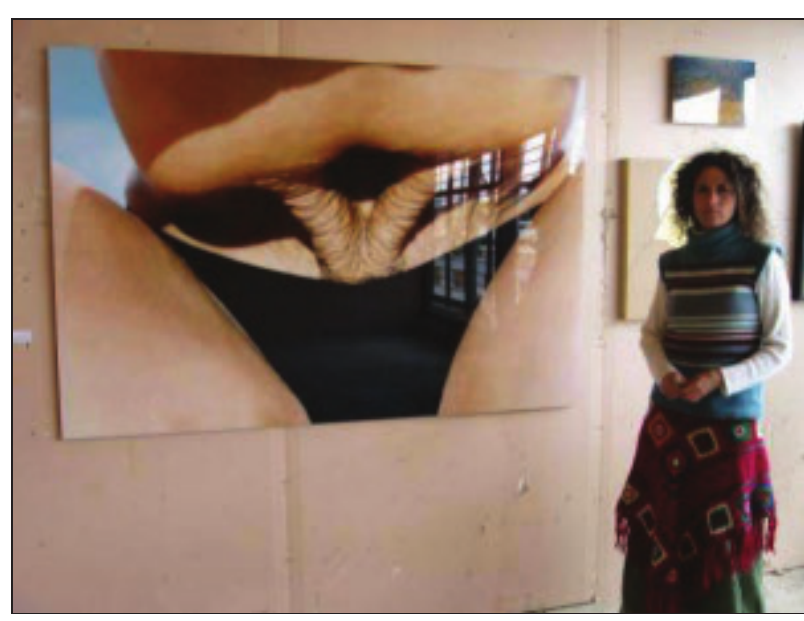
Figure 36: Shira Richter, the artist, standing with The Mother, Daughter, and Holy Spirit from the Mother, Daughter, and Holy Spirit series , C-prints, 120x180 centimeters,